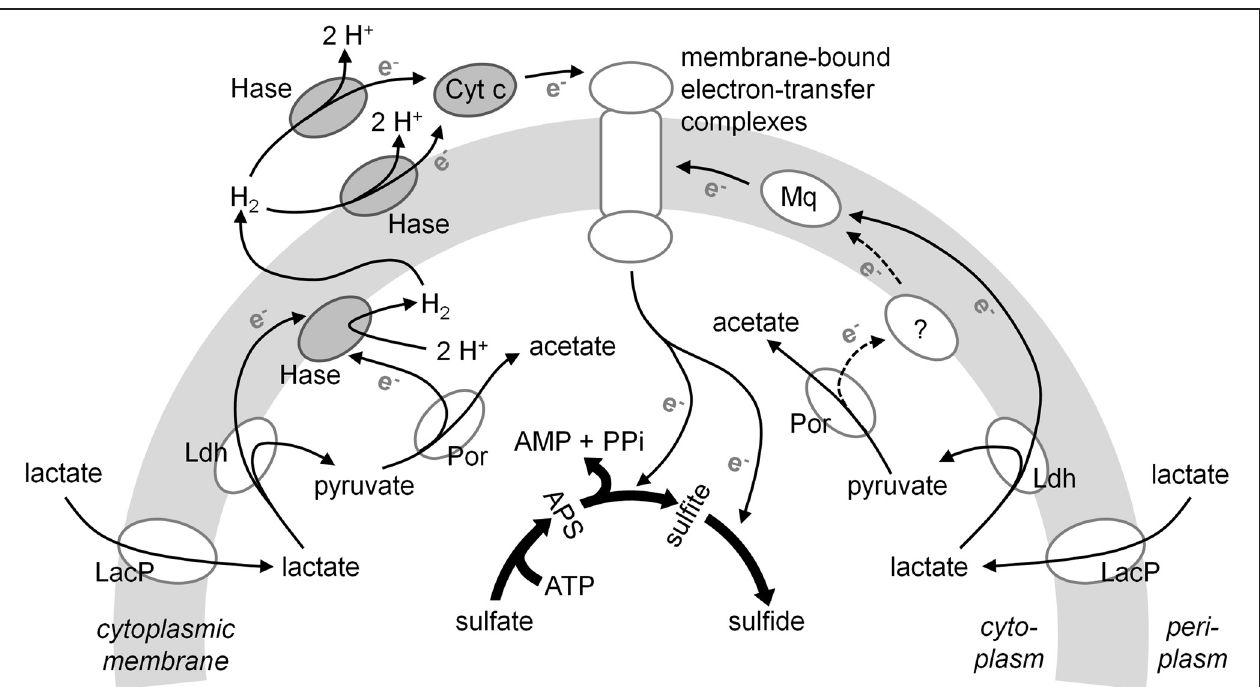
pathway can transfer electrons to the membrane-associated menaquinone pool (Keller and Wall, 2011). Dark gray ovals indicate enzymes and electron carriers deleted in the mutant strains used in this study. Abbreviations: LacP, lactate permease; Ldh, lactate dehydrogenase; Por, pyruvate-ferrodoxin oxidoreductase; Hase, hydrogenase; Cyt. c , cytochrome c ; Mq, menaquinone pool; APS, adenosine 5 (cid:2) -phosphosulfate. Dashed lines and the question mark indicate currently hypothetical pathways and